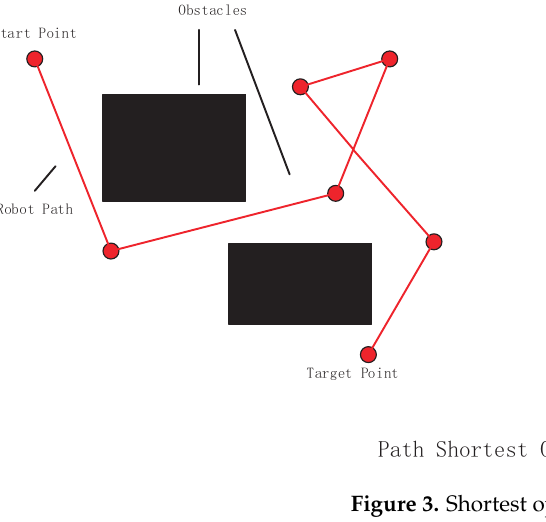
Figure 3. Shortest operator.